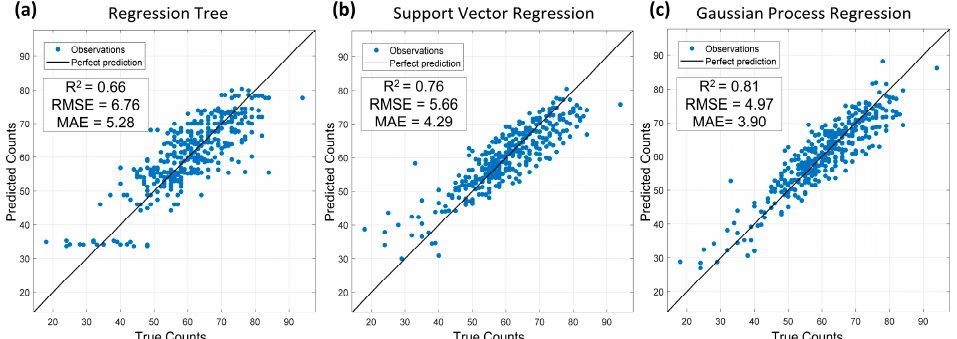
Figure 3. Cross-validation of machine learning model results. Three machine learning regression models (a) Regression tree, (b) Support vector regression and (c) Gaussian process regression models were applied on the training dataset. True counts are manually measured seedling emergences and predicted counts use a given model.